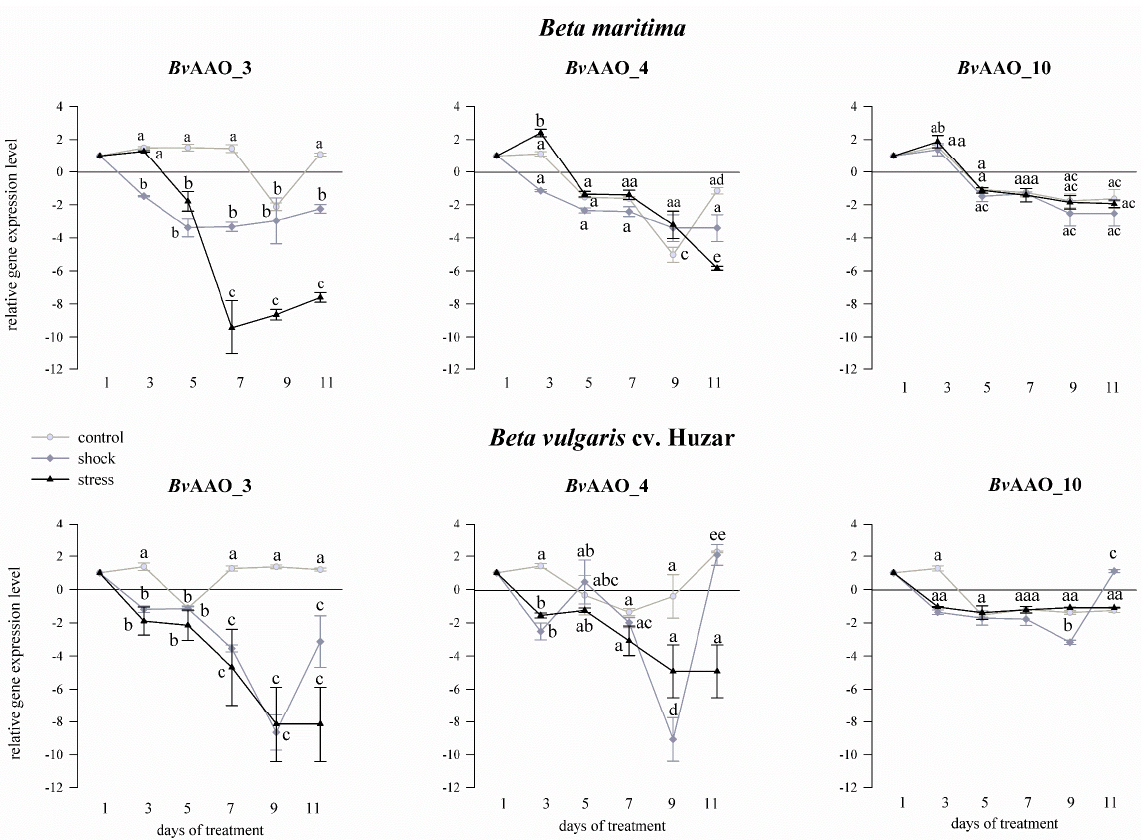
Figure 5. Expression profiles of AAO genes Bv AAO_3, Bv AAO_4 and Bv AAO_10 determined in leaves of Beta vulgaris ssp. maritima and Beta vulgaris cv. Huzar subjected to drought shock or stress. Control − light gray lines, drought shock − gray lines, drought stress − dark gray lines. Different letters denote significant differences at p < 0.01 (ANOVA followed by Tukey’s test). “Whiskers” indicate standard deviation.